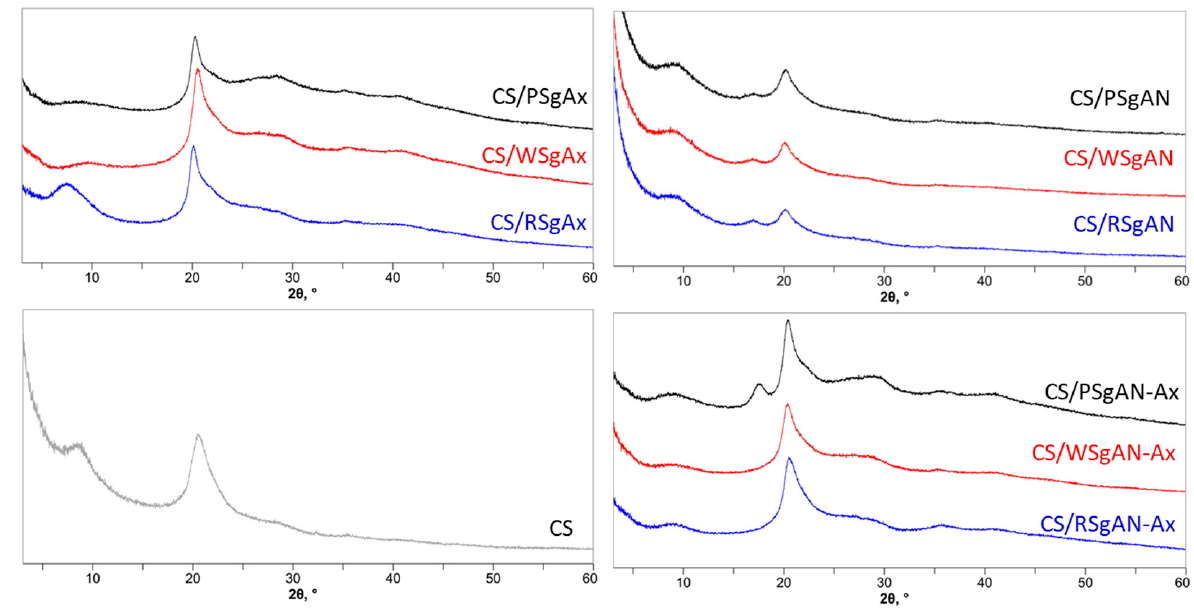
Figure 6. X-ray diffractograms of CS/SgAx, SgAN and SgAN-AX composite beads as compared to bare CS.